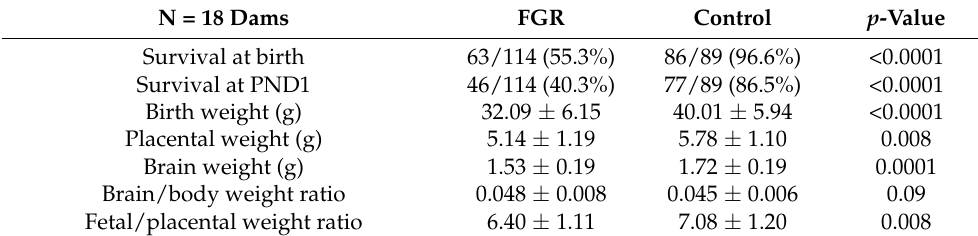
Table 1. Survival and biometrics.